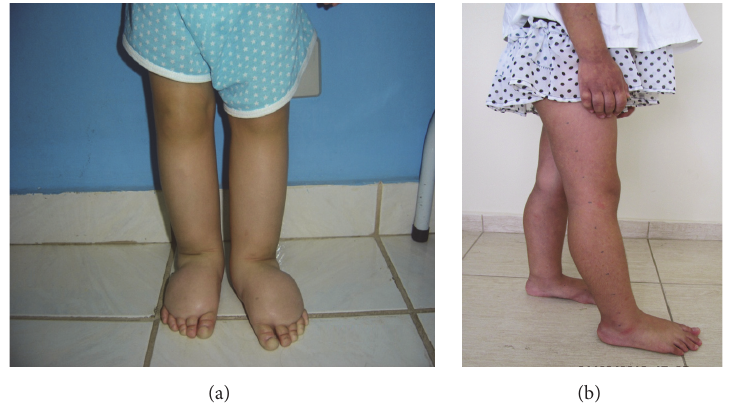
Figure 1: Images of the child (a) before treatment and after treatment